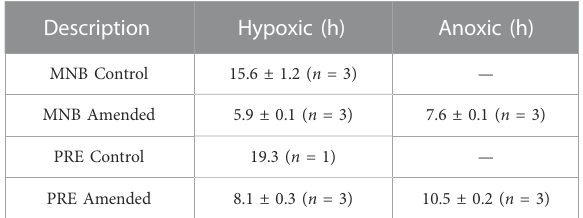
TABLE2Timesatwhicheachincubationreached thehypoxic( ≤ 94 μ M)and anoxic thresholds. Values represent the mean ± standard error of up to three replicate